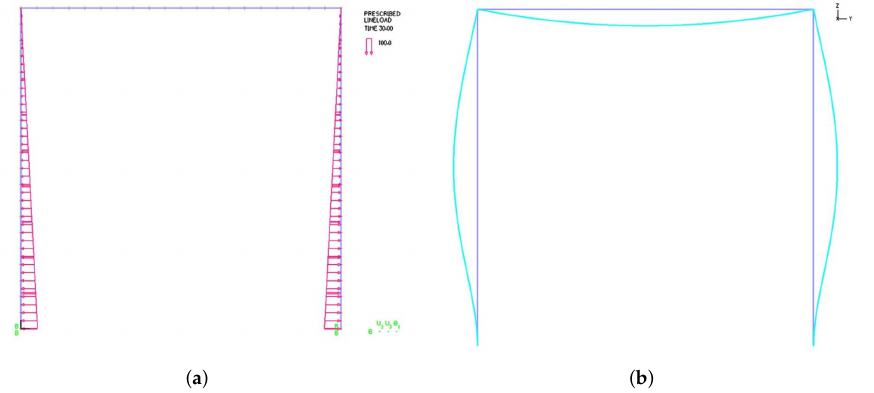
Figure 8. ADINA finite element model of this two-dimensional beam-column structural system. ( a ) 2D model, ( b )